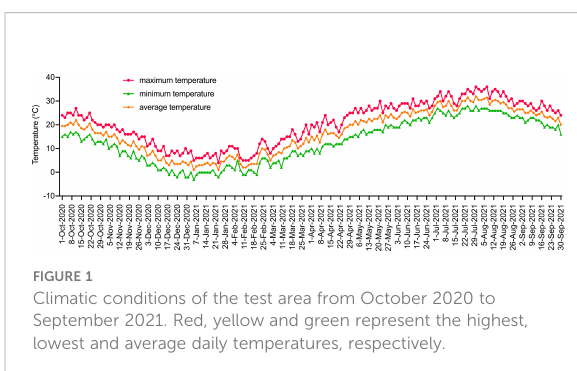
FIGURE 1 Climatic conditions of the test area from October 2020 to September 2021. Red, yellow and green represent the highest, lowest and average daily temperatures,